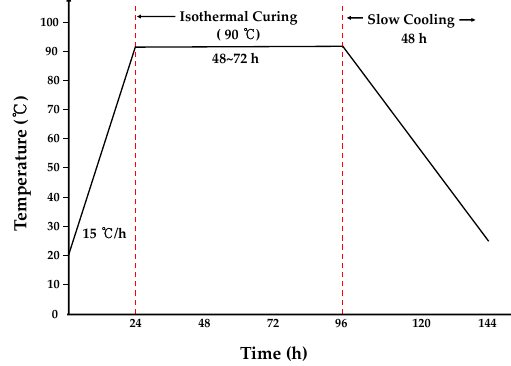
Figure 2. Heating cycle of high-temperature steam curing.